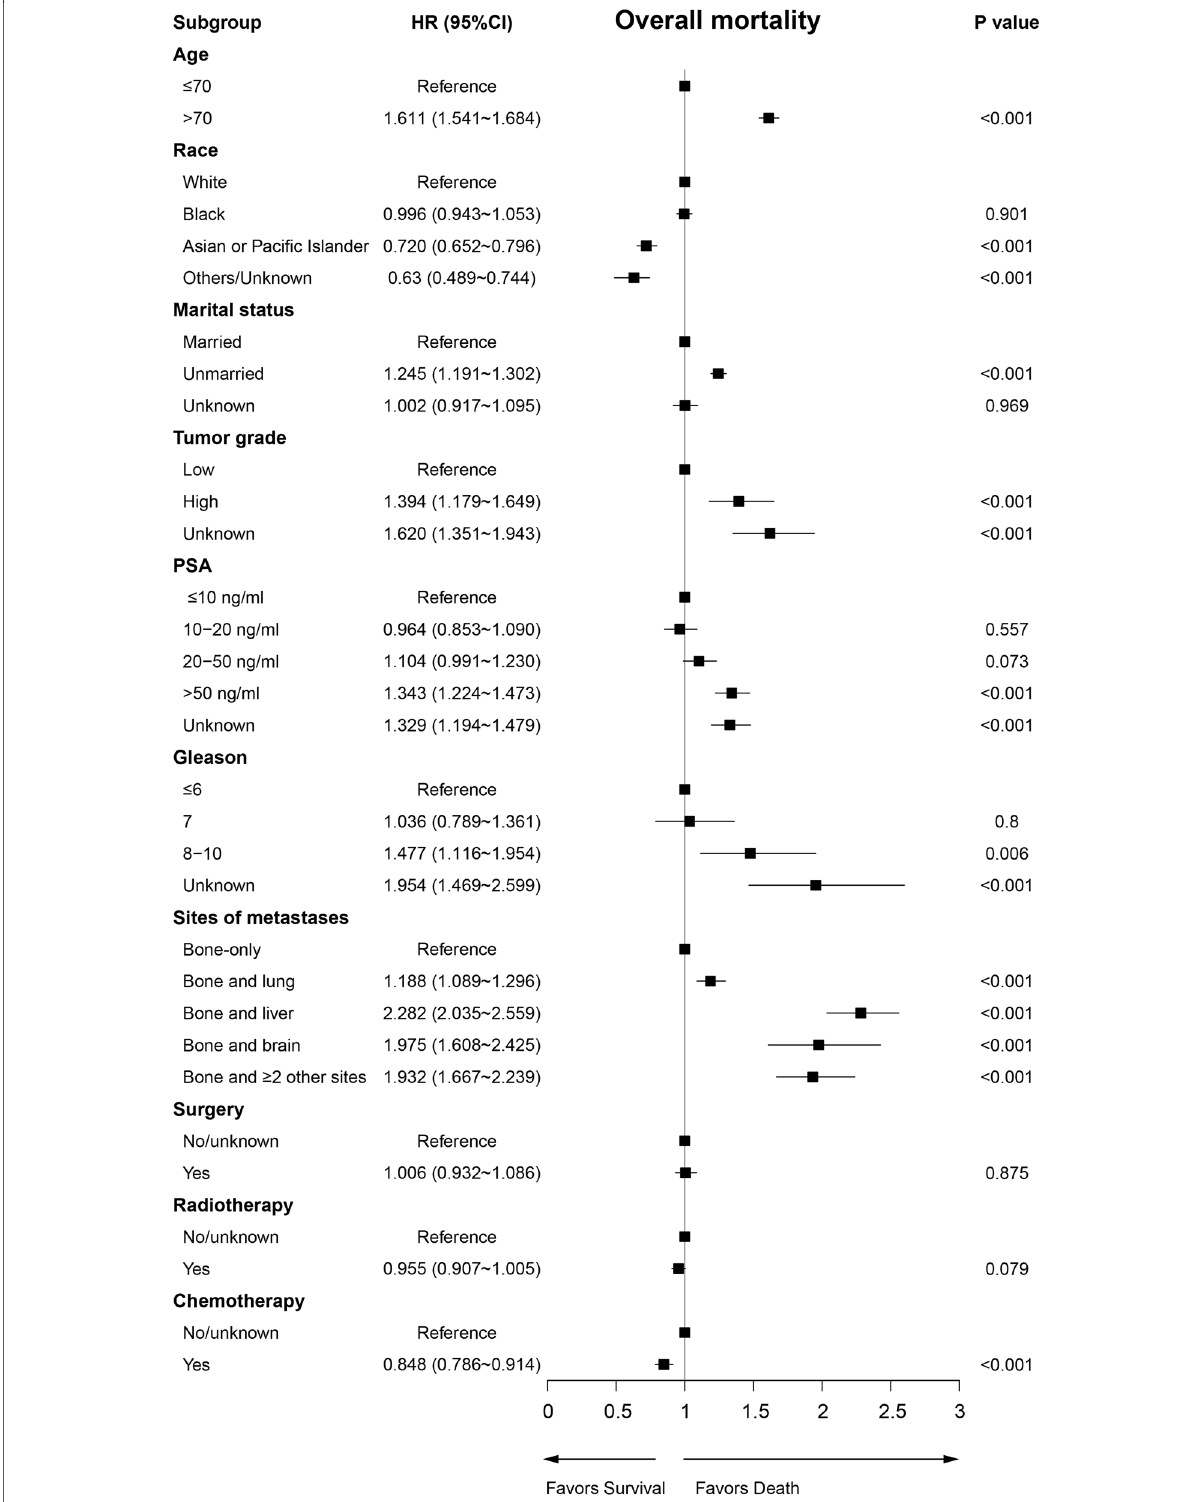
Fig. 3 Multivariable Cox proportional hazards models were used to analyze associations of patients’ characteristics, sites of metastases and treatment modalities against survival in de novo PCa patients with bone metastases. Hazard ratios (HRs) and 95% confidence intervals (CIs) were estimated and summarized with forest